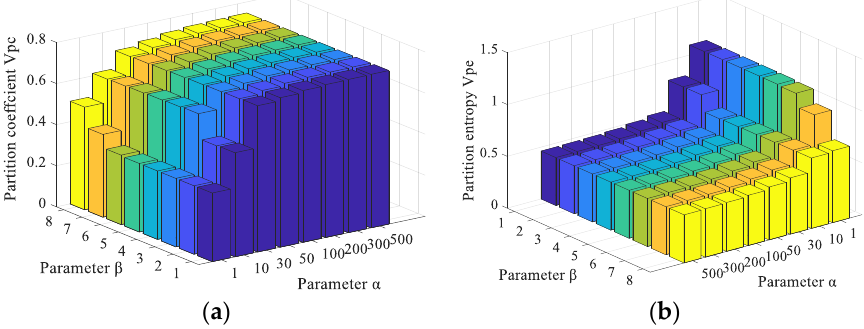
Figure 10. The partition coe ffi cient v pc and partition entropy v pe values of FCM_NNS with di ff erent α